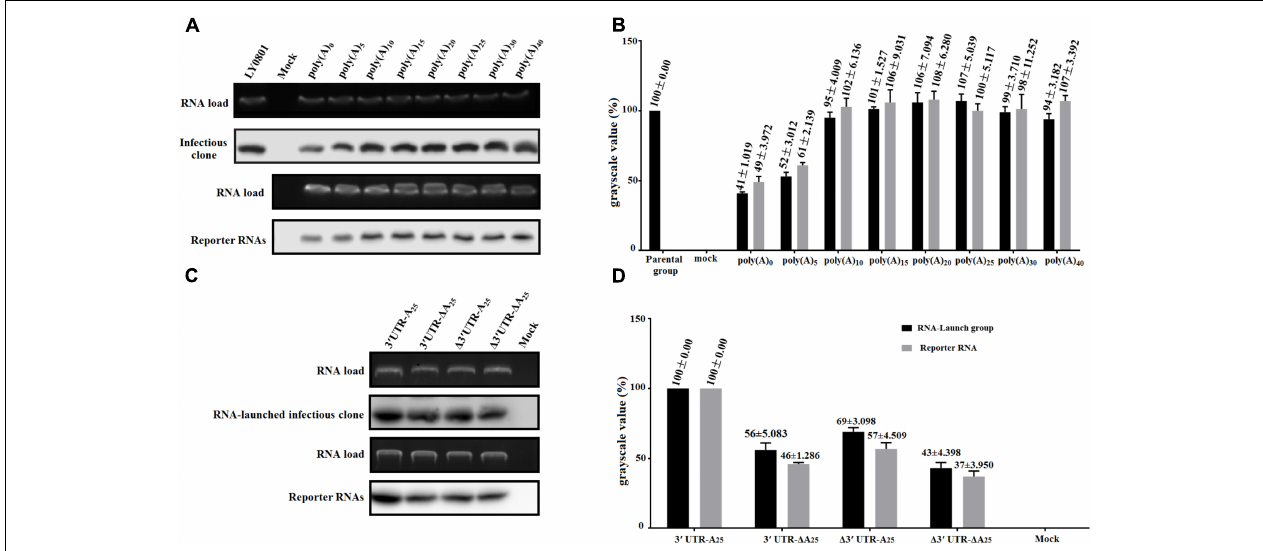
FIGURE 2 | Effects of poly(A) tail length and 3 (cid:48) UTR on RNA stability. DEFs transfected with 0.8 µ g of the in vitro transcribed RNA were collected at 4 hpt and were immediately used for total RNA extraction. The samples were analyzed by 1.5% formaldehyde-agarose gel electrophoresis and autoradiography. Digoxigenin (DIG)-labeled RNA probes (based on 81–351 of LY0801) was used to in this assay. The gels show the amount of input RNA remaining at 4 hpt. (A) The remaining amount of pR-DHAV-1-A n or pDHAV-1-A n was measured at 4 hpt. (B) The grayscale value of represent the mean ± standard deviation of three replicate experiments for poly(A) n group. The grayscale value of parental group was set as 100%. (C) The remaining amount of complete/mutated RNA-launched infectious clone or reporter RNA was measured at 4 hpt. The upper panel shows the ethidium bromide staining of the agarose gel loaded with aliquots of 800 ng RNAs. (D) The average grayscale values of three replicate experiments for each group. The grayscale value of pR-DHAV-1 or pDHAV-3 (cid:48) UTR-A 25 was set as 100%.